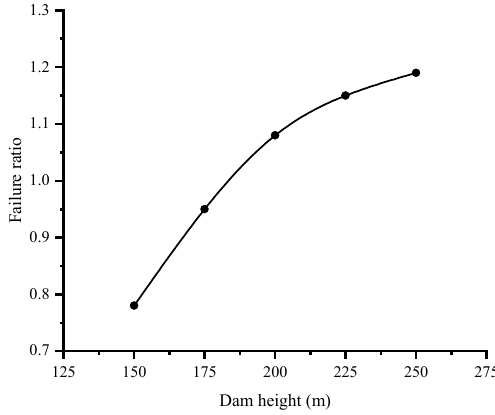
Figure 12. Relationship between failure ratio of ACC that meets YSFCS and dam height.